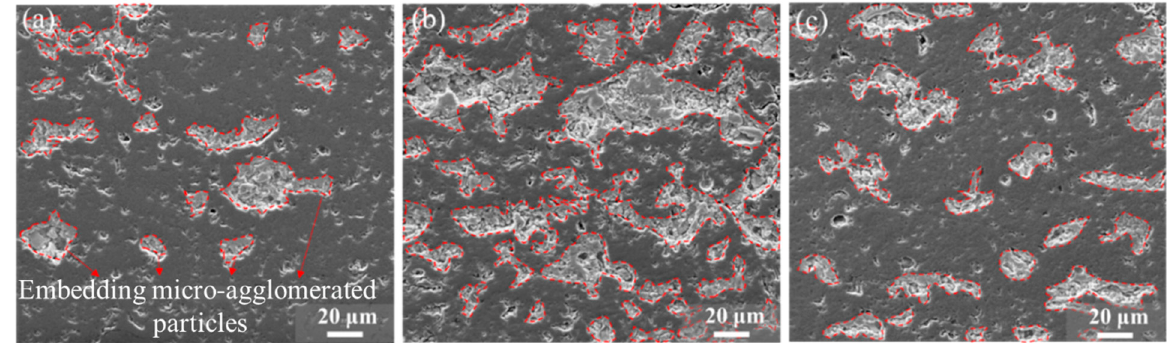
Figure 4. Micro-agglomerated particles embedded in matrix coating with different contents and distributions: ( a ) less content and non-uniform distribution, ( b ) excessive and unevenly distributed, and ( c ) moderate content and uniform dis- tribution.